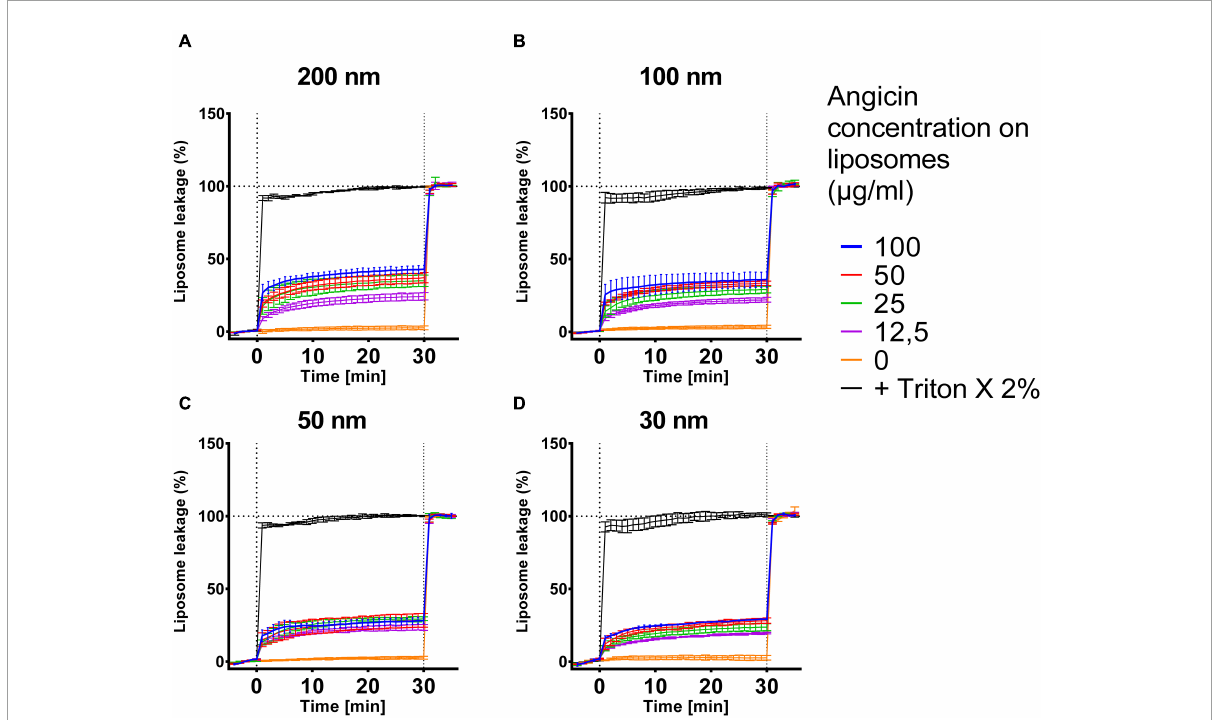
FIGURE5 Effect of Angicin on virus-like liposomes. Liposomes that resemble virus particles with sizes of 200 nm (A) , 100 nm (B) , 50 nm (C) or 30 nm (D) containing 50 mM carboxyfluorescin were added to 96-well plates and baseline fluorescence was recorded once per minute for 5 min. Angicin was then added at indicated concentrations and fluorescence increase (indicating membrane disruption) was recorded for 30 min with one measurement per minute. Triton X-100 was then added to all wells at 2% final concentration to induce total lysis. Background signal was subtracted (signal of liposome prior to addition of compounds) and normalized to fluorescent signal achieved in each well after complete liposome leakage induced by addition of 2% (v/v) Triton X-100. Depicted is the mean of two to three experiments ± standard